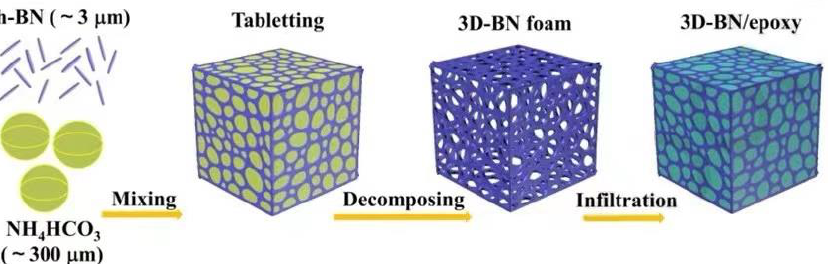
Figure 8. Schematic diagram of the formation process of 3D-BN/epoxy composite. Adapted with permission [50], Copyright 2020, Chemical Engineering Journal.